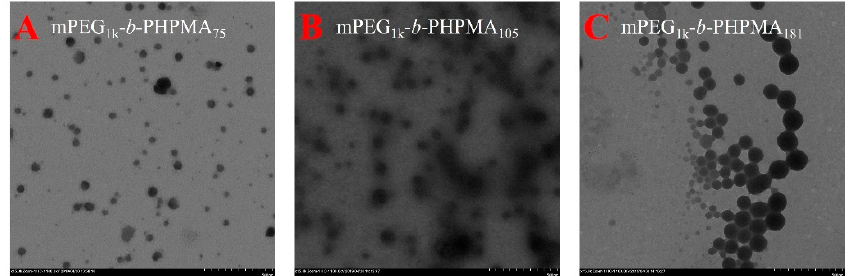
Figure 4. TEM images ( A – C ) of micelles from mPEG 1k - b -PHPMA x (x = 75, 105, and 181, respectively)